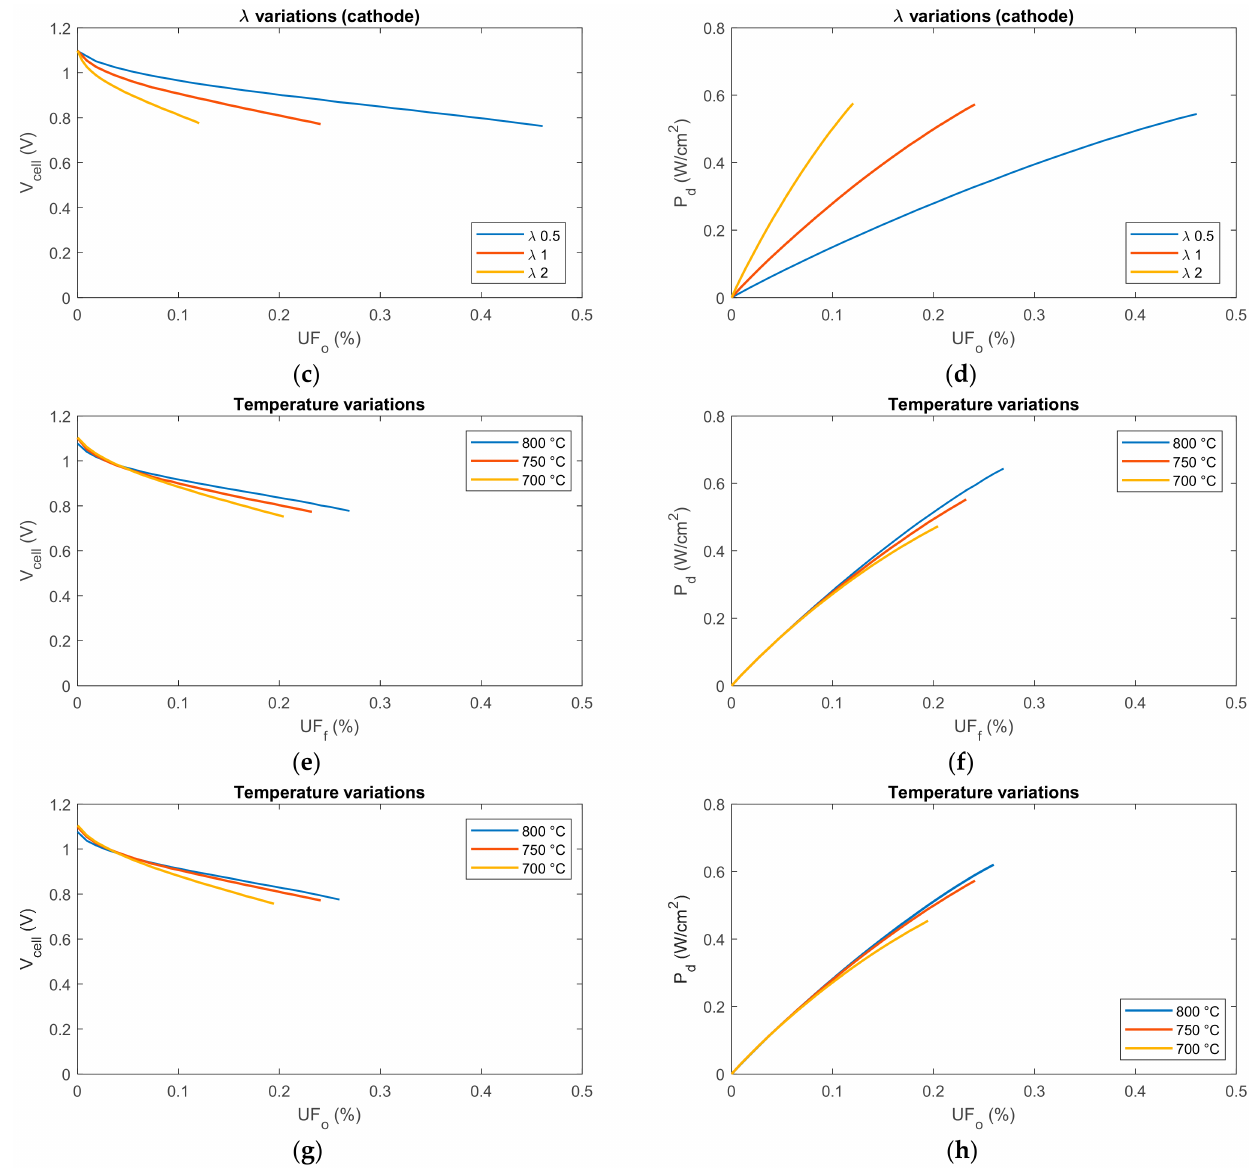
Figure 7. Experimental performance curves vs. UF f & UF o : ( a , b ) UF f -H 2 % vol variations (T = 750 ◦ C; λ = 1.4); ( c , d ) UF o - λ variations (T = 750 ◦ C; H 2 50% vol ); ( e , f ) UF f -T variations (H 2 50% vol ; λ = 1); ( g , h ) UF o -T variations (H 2 50% vol ; λ =